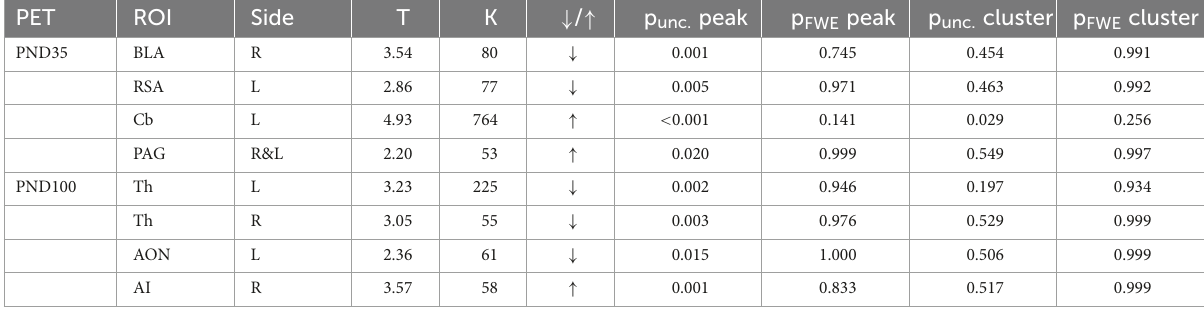
TABLE 1 Brain metabolic changes in maternal immune stimulation (MIS) vs. Saline, in adolescence and adulthood, in voxel-based analyses. PET ROI Side T K ↓ / ↑ p unc. peak p FWE peak p unc. cluster p FWE cluster PND35 BLA